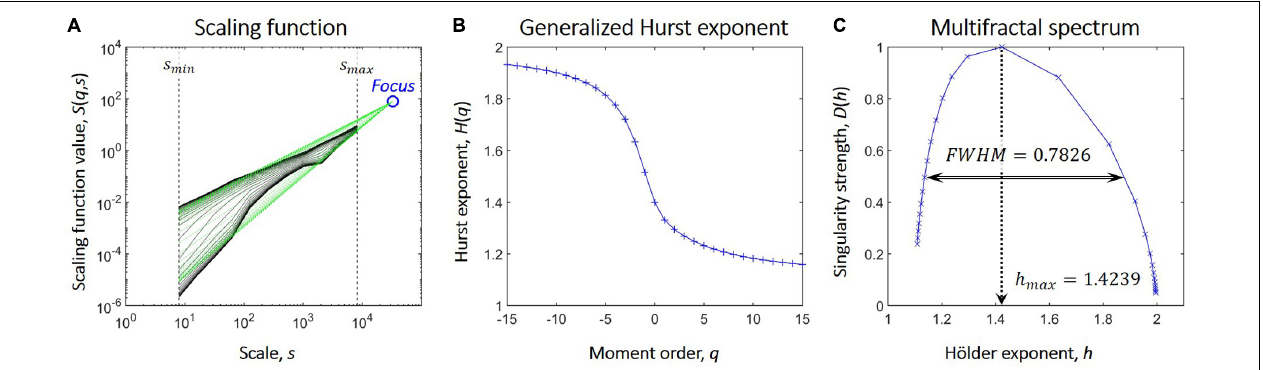
FIGURE 1 | Steps of focus-based multifractal analysis. (A) After the scaling function (marked in black) is acquired, linear regression is used to fit power-law functions (marked in green) at each moment order q . On double logarithmic plots these appear as linear functions whose slopes are the scaling exponents. Also, in case of finite length signals, these converge to one point, the Focus, that is used as a reference point during regression. (B) The generalized Hurst exponent, H ( q ) is acquired as the scaling exponents of the functions fitted on the scaling function at each value of q. The focus-based formalism enforces the monotonously decreasing nature of H ( q ); a prerequisite for Legendre transformation. (C) The multifractal spectrum is acquired from H ( q ) via Legendre transformation and is described by the Hölder exponent at its maximal value ( h max ) and its full width at half maximum ( FWHM ).